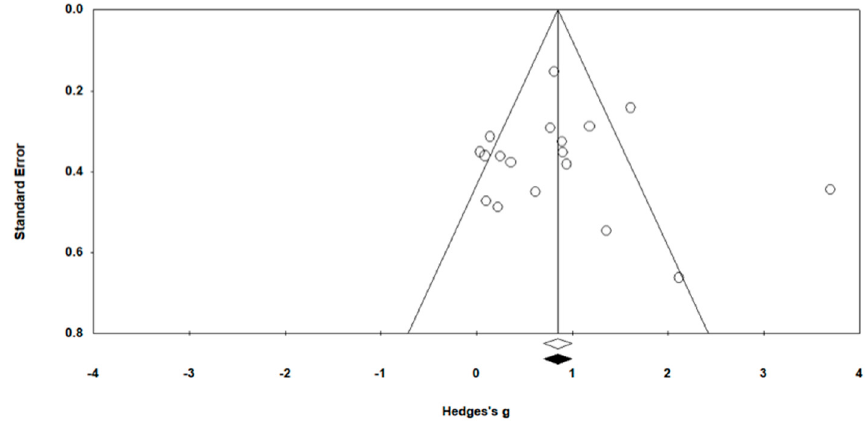
Figure 2. Funnel Plot of Standard Error by Hedges’ g.